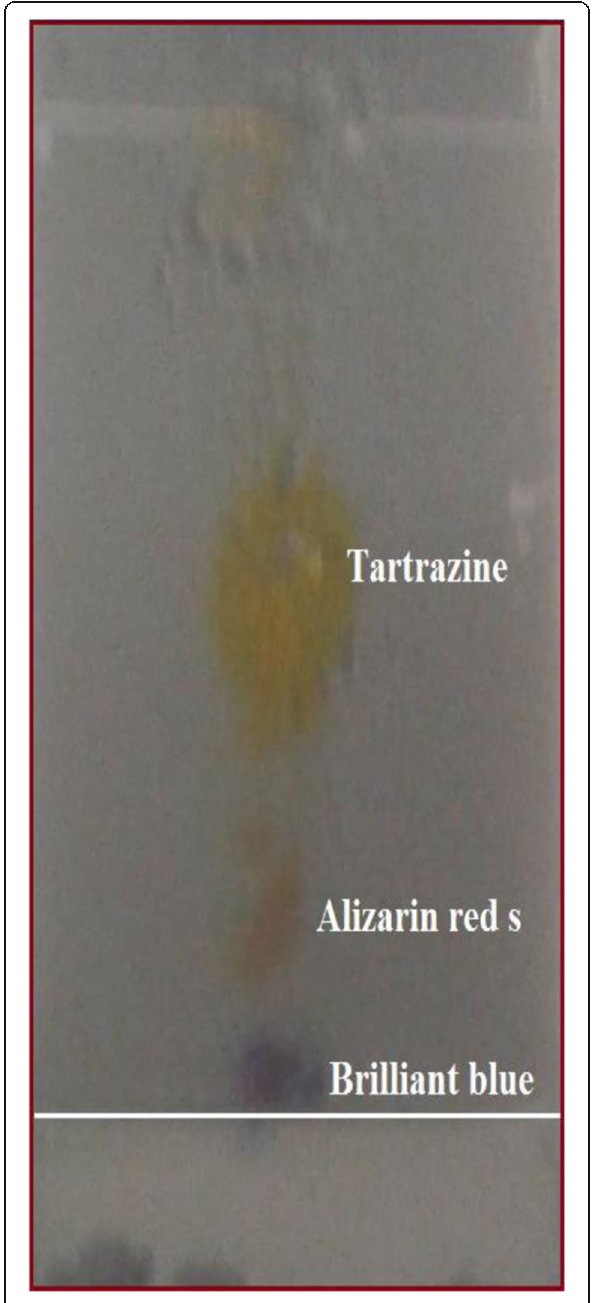
Fig. 6 Separation achieved separation (or resolution) of three- component mixture of dyes (tartrazine, alizarin red S and brilliant blue) on Pani@SIG-ES layer developed with M 3 mobile phase